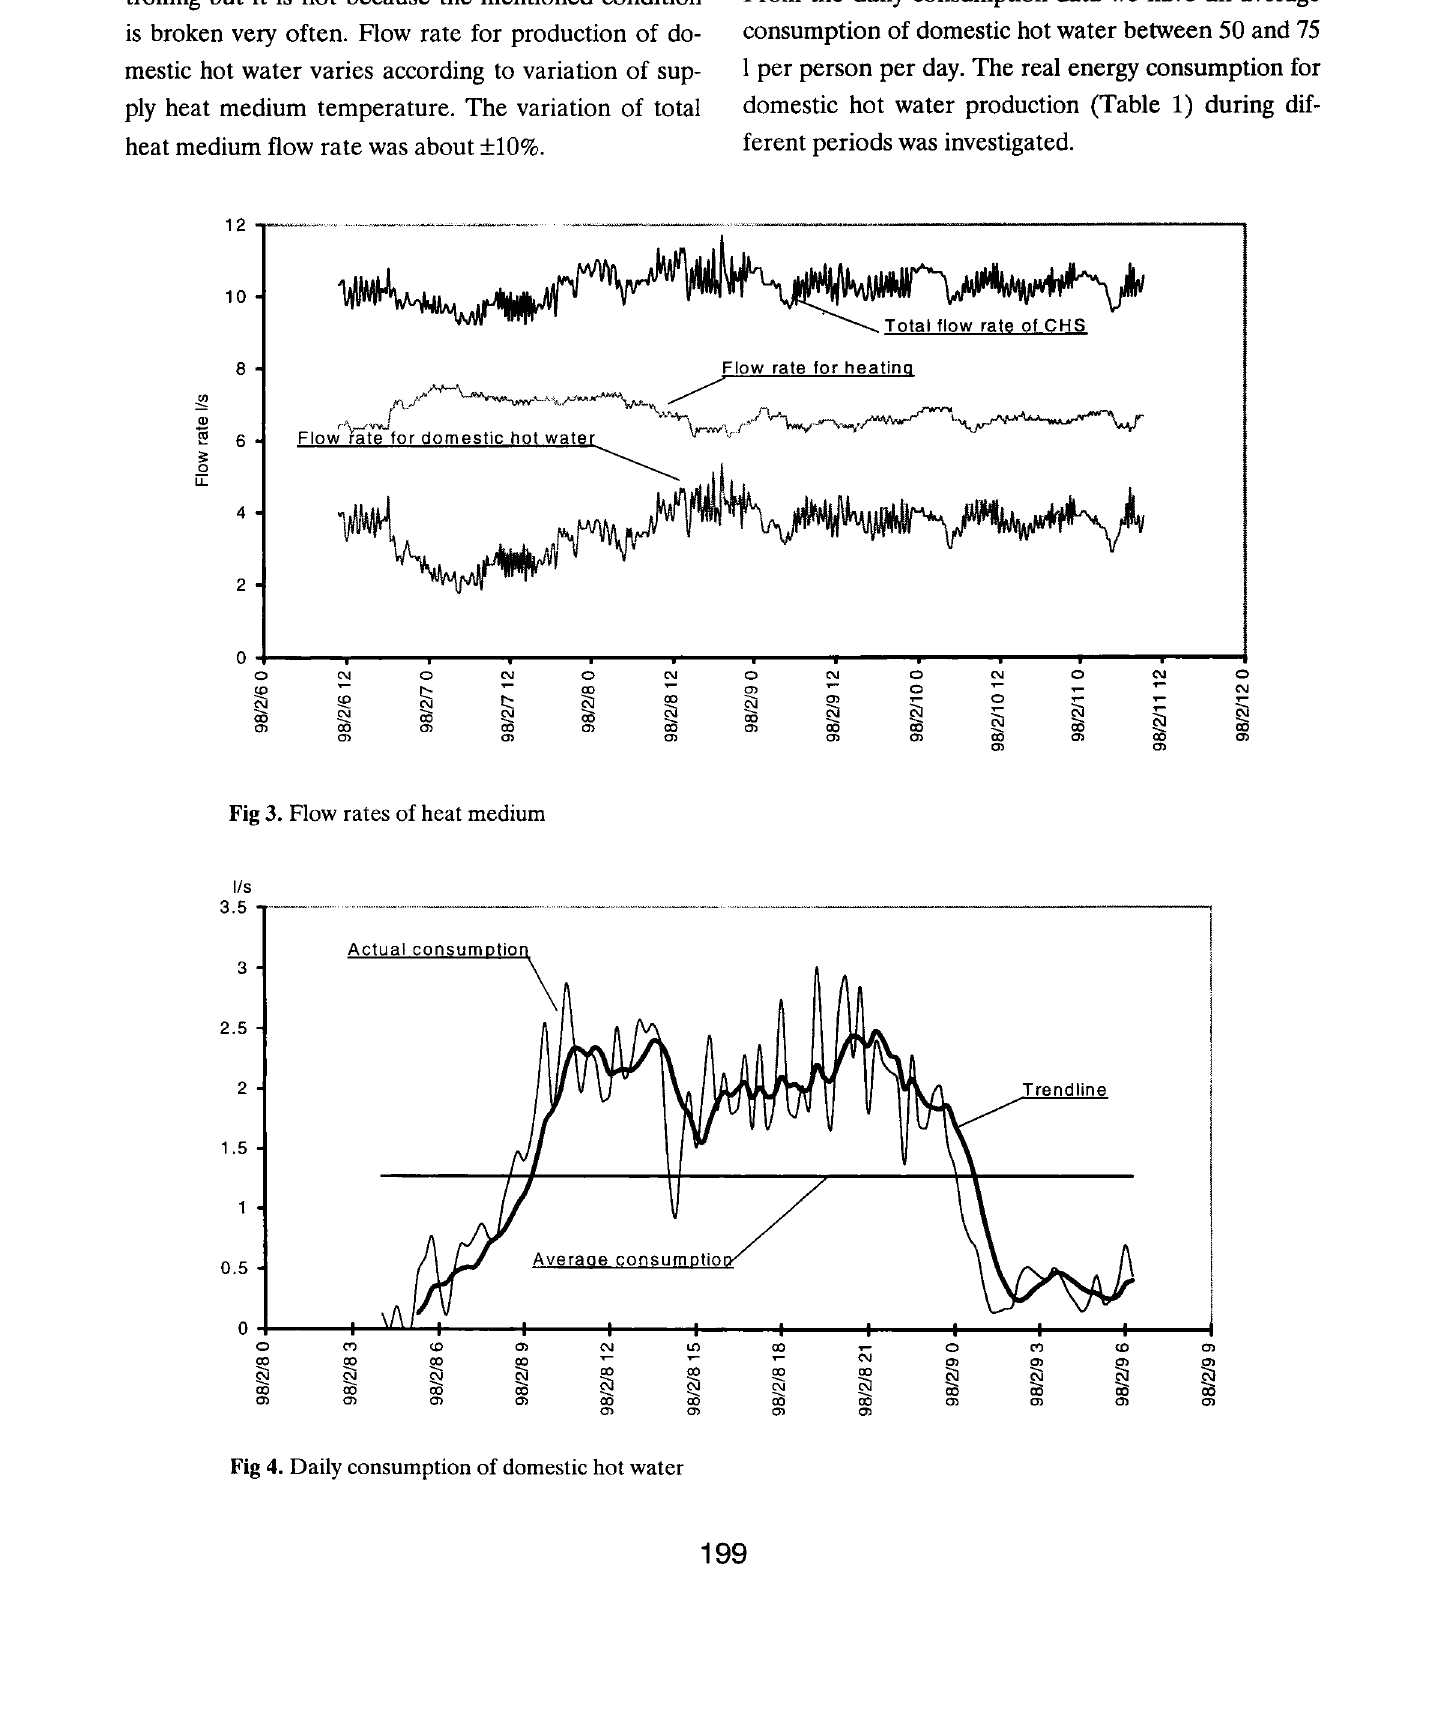
Fig 4. Daily consumption of domestic hot